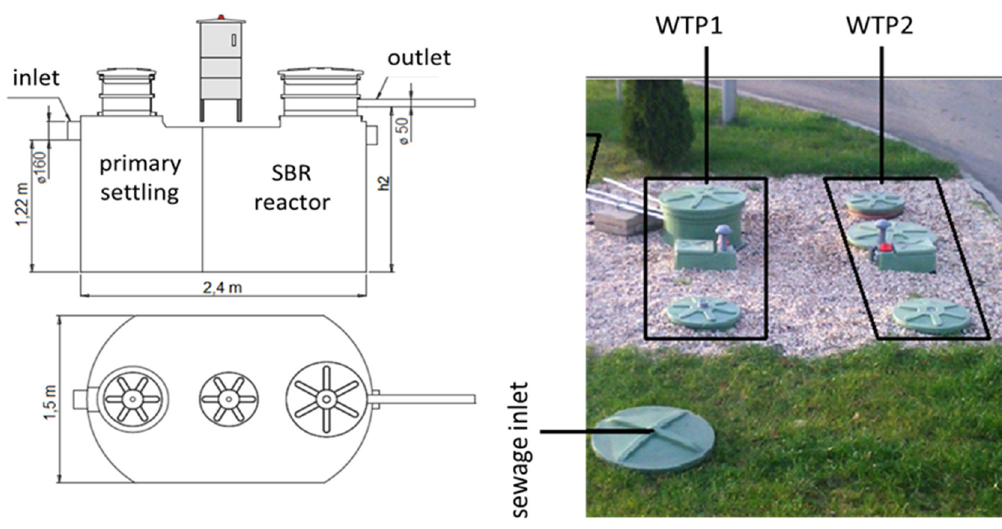
Figure 1. Scheme of wastewater treatment plants.